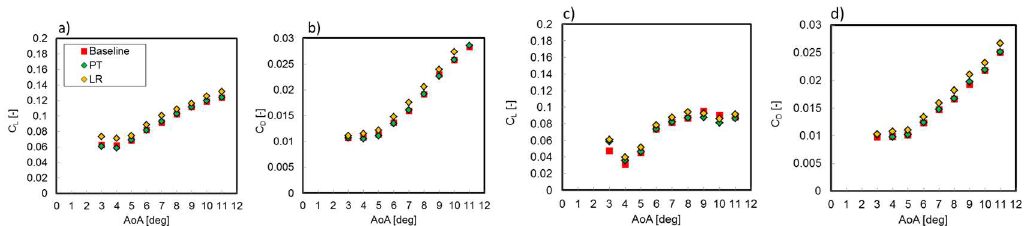
Figure 2. Drag coefficient c D versus Angle of Attack AoA for baseline, PT and LR models at 4 m/s ( a , b ) and 8 m/s ( c , d ). Baseline in red ( ■ ) and PT in green ( ♦ ) and LR in yellow ( ♦